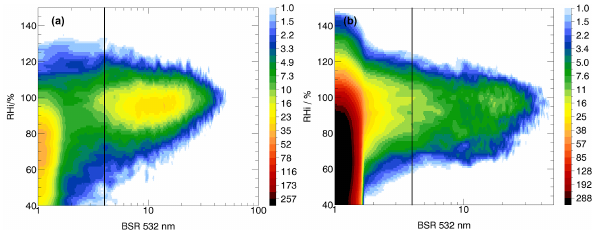
Figure 10. Histogram of the joint occurrence of the relative hu- midity over ice (RHi) and the extinction corrected backscatter ratio (BSR) at 532nm (a) for a fully developed cirrus cloud on 4 Novem- ber 2010 and (b) for a transient cirrus cloud on 3 November